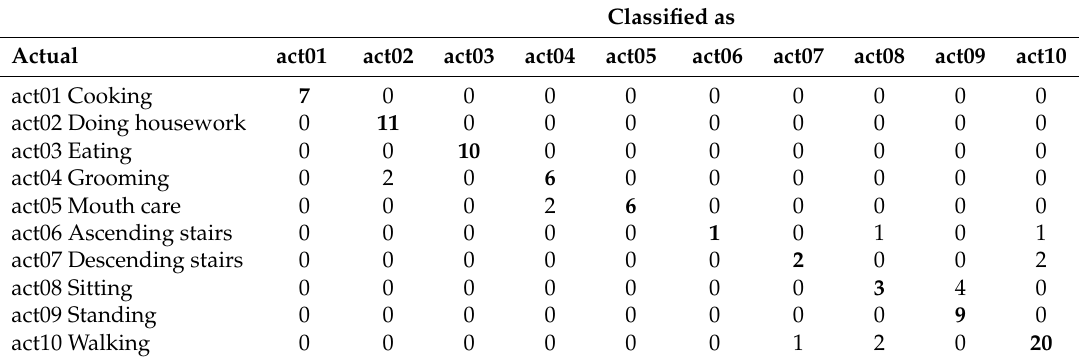
Table 6. Confusion matrix of classification results of Table 4 using K-Nearest Neighbours